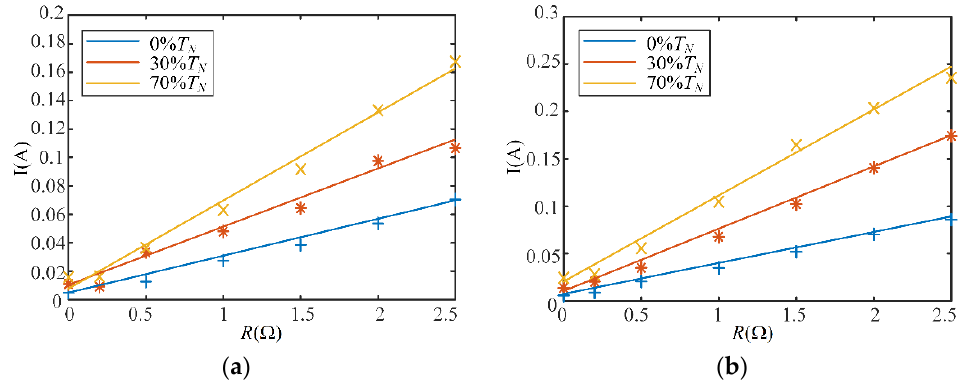
Figure 10. Motor negative sequence currents and fitting curves: ( a ) The motor operates at 10 Hz. ( b ) The motor operates at 30 Hz.